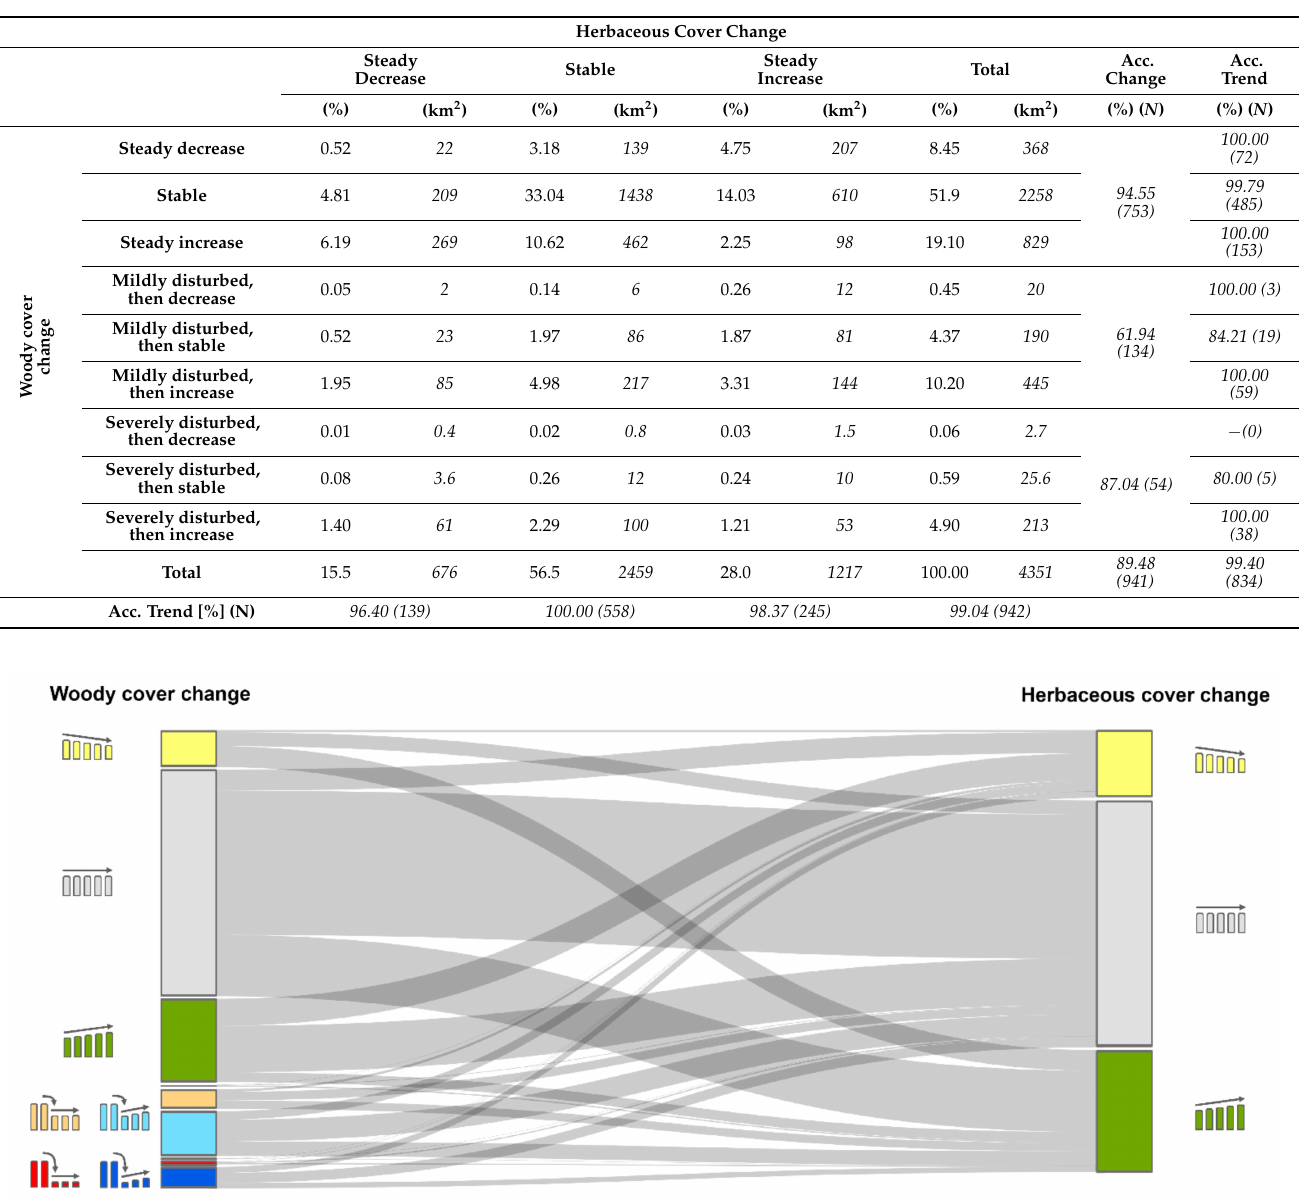
Table 5. Area statistics of cover change categories for both vegetation components.